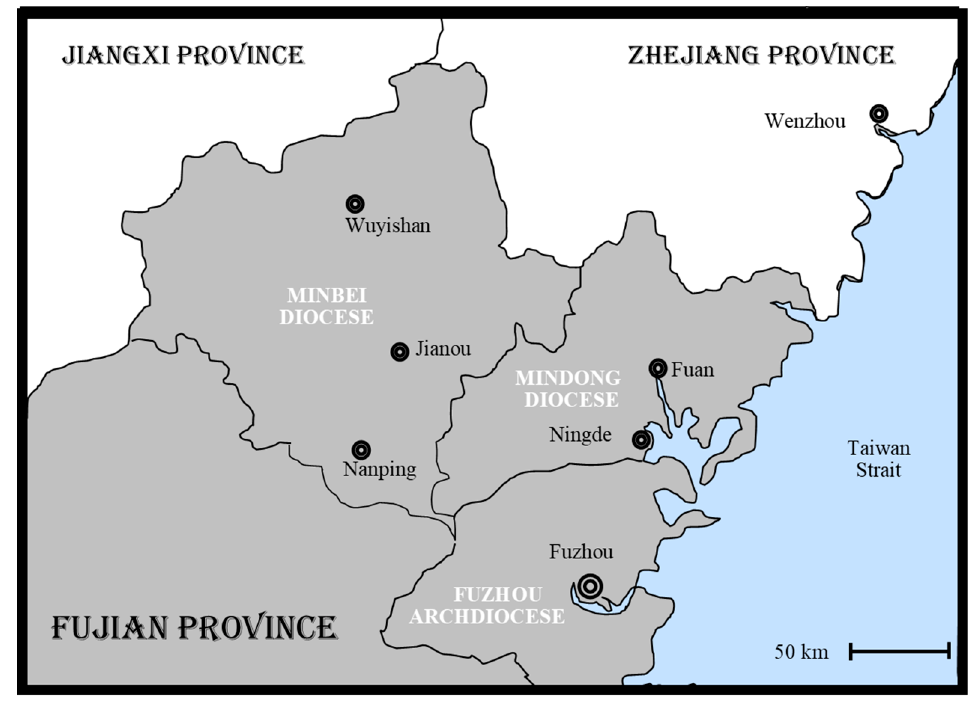
Figure 1. Simplified Map of Northern Fujian.